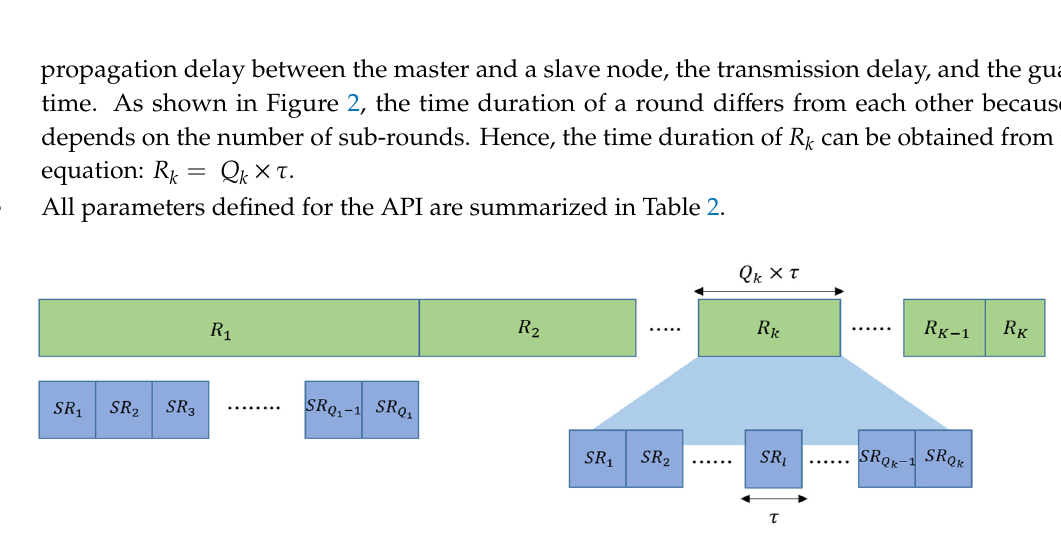
Figure 2. The illustration of the concept of a round and a sub-round in the API protocol. Table 2. The description of parameters for the API protocol.